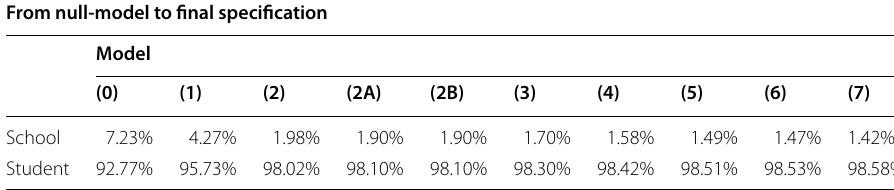
Table reports ICC as a proportion of total variance using adjusted ICC that is the mean random effect variance, which is based on the random effect variances for each value of the random slope suggested by Johnson et al. (2014)